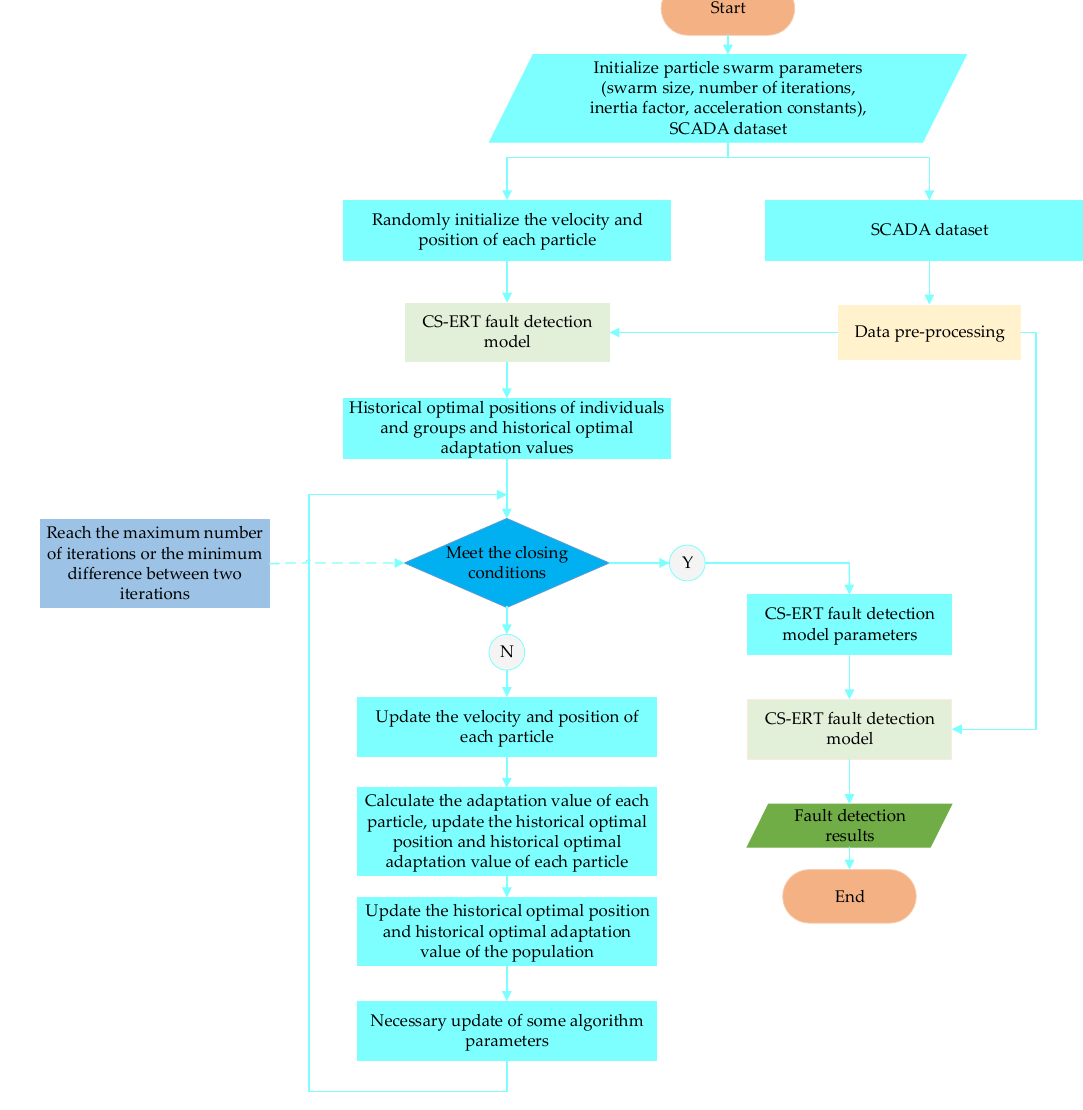
Figure 5. Flow chart of CS-ERF converter valve fault detection based on IPSO.